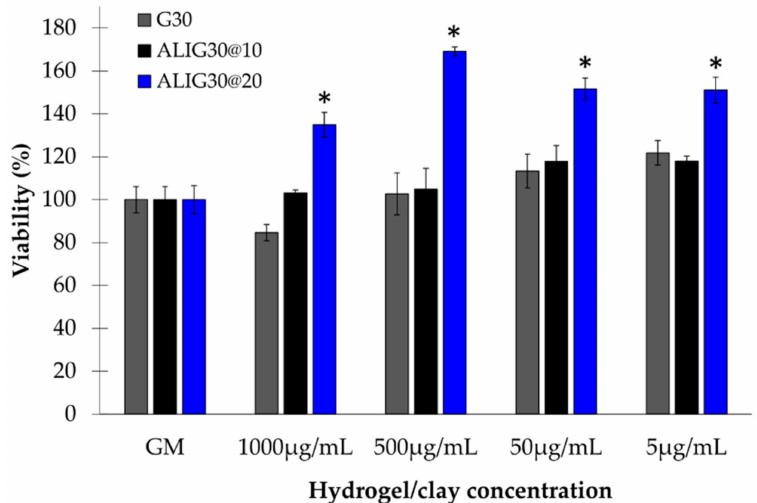
Figure 2. Biocompatibility tests of ALIG30@20 (blue). Viability (%) vs. hydrogel or clay concentration (% w / w). GM (growth medium) indicates the control. G30 and ALIG30@10 results (taken from Garc í a-Vill é n et al. [17]) were included to compare viability results of hydrogels with di ff erent concentrations. Mean values ± s.e.; n = 8. Significant di ff erences, compared to GM, are marked with (*).